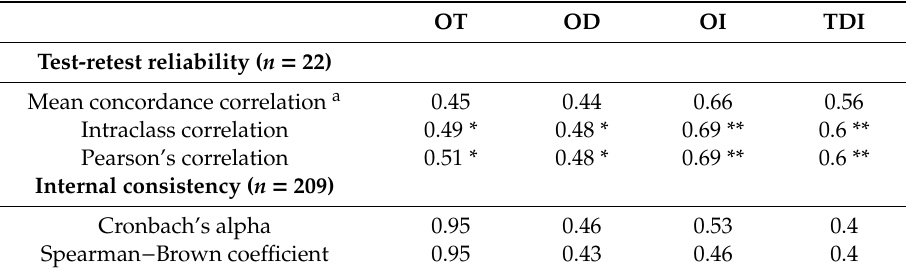
Figure 3. Graphical representation of Sniffin’ Sticks Olfactory Test scores by age groups. ( A ) OT, OD, and OI scores. ( B ) TDI score. Table 3. Internal consistency and test − retest